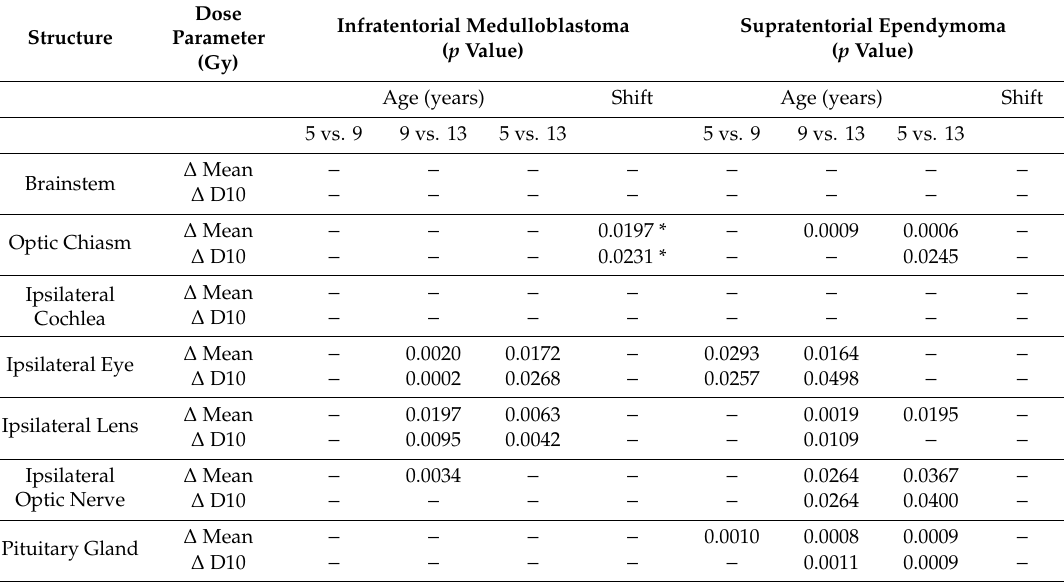
Table 5. Dependence of dose reduction ( ∆ IMRT-IMPT) on patient age and target shift.